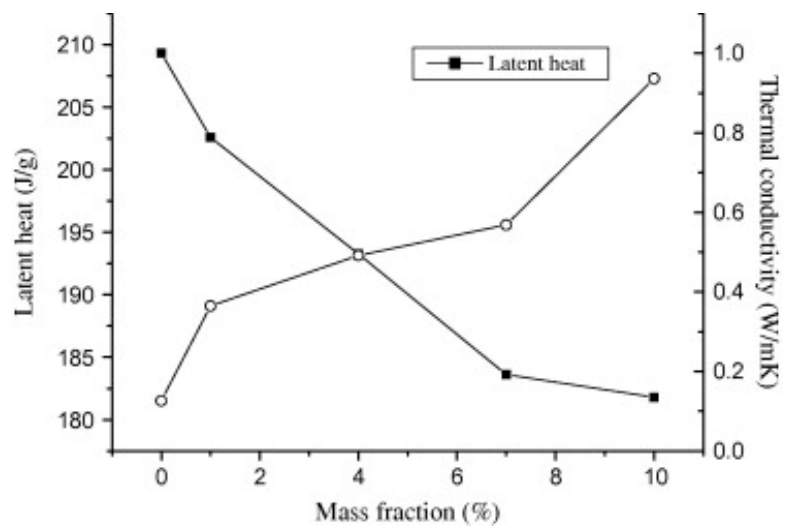
Figure 14. Latent heat vs. thermal conductivity vs. mass fraction of paraffin/nano-graphite NEPCM. (Reprinted with permission from ref. [22]. Copyright 2013 Applied Energy)